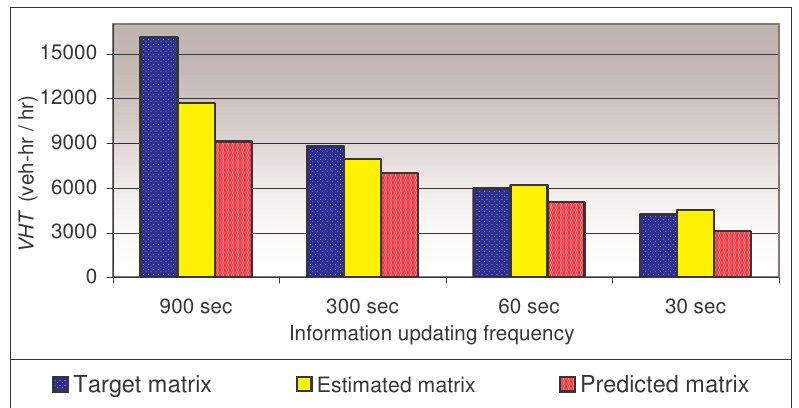
Figure 3. Changes in the VHT (veh-hrs/hr) for different information updating frequencies and loading conditions